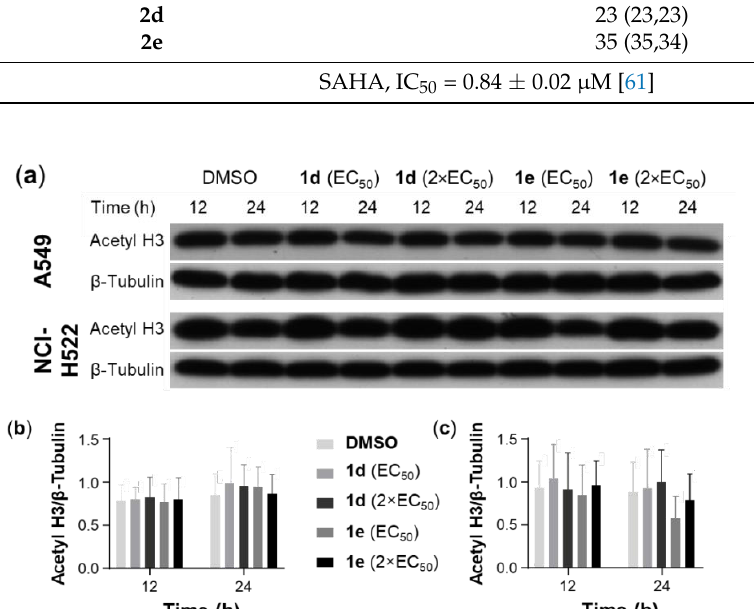
Figure 6. Effect of 1d and 1e on the expression of acetyl-H3 in A549 and NCI-H522 cells. ( a ) Cell lysates of A549 cells, which were treated with 1d and 1e at 1 × and 2 × the EC 50 concentrations for 12 and 24 h, were subjected to Western blotting with a specific antibody against acetyl H3. Blots shown are representative of n = 3. Scanning densitometry of the ratio of acetyl-H3 to β-tubulin in ( b ) A549 and ( c ) NCI-H522 cells. Vehicle control cells were treated with DMSO (0.5%). Bars represent mean ± SEM ( n = 3). Data were analyzed with a two-way ANOVA coupled with a Bonferroni post hoc test. No statistical significances were